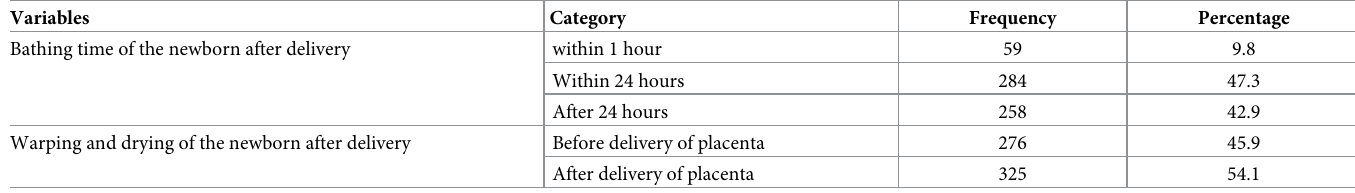
Table 6. Thermal care practice among home delivery women, in Guto Gida district, Oromia regional state, Ethiopia, September 2020, (n = 601). Variables Bathing time of the newborn after